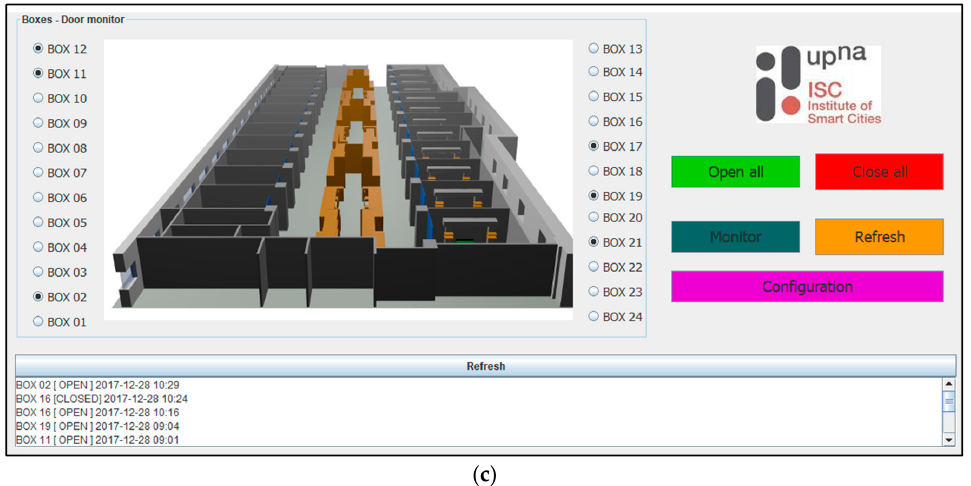
Figure 19. Application interface: ( a ) application running on a laptop; ( b ) equipment location control; and ( c ) boxes door monitoring.